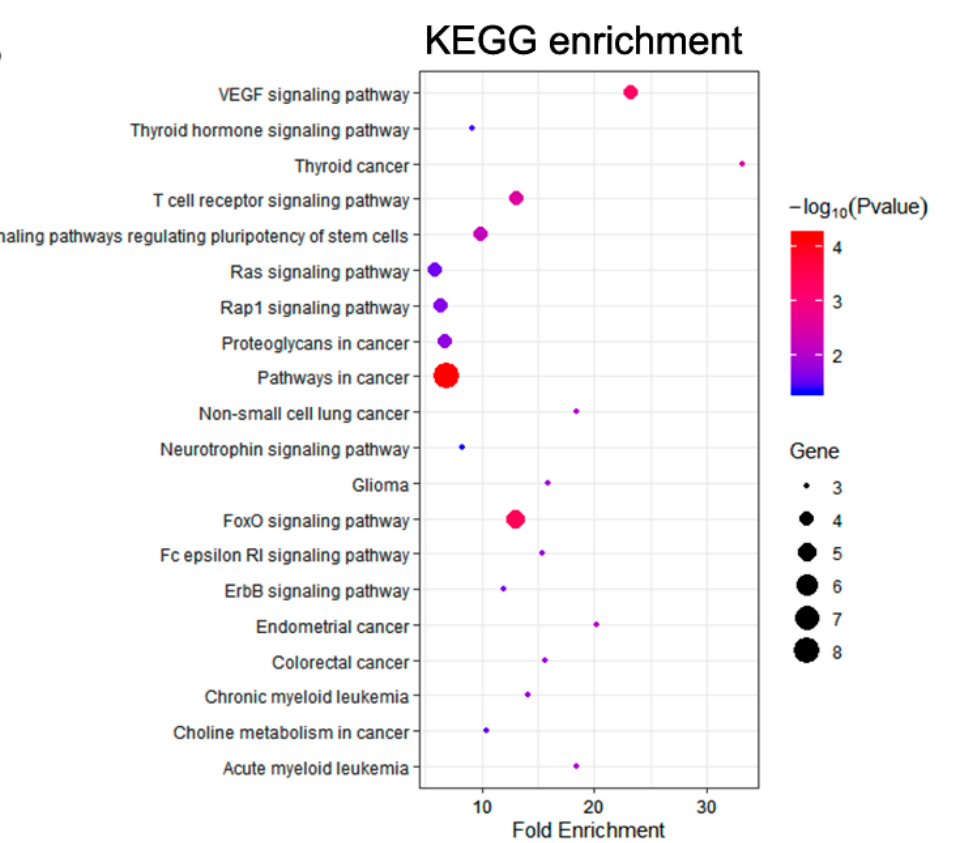
Figure 2. The functional enrichment analysis. ( A ) The most significant GO terms of the 27 common genes. Many studies have indicated that the great majority of GO terms are related to cancer development. ( B ) The most significant pathways of the 27 common genes. All of these pathways play a role in